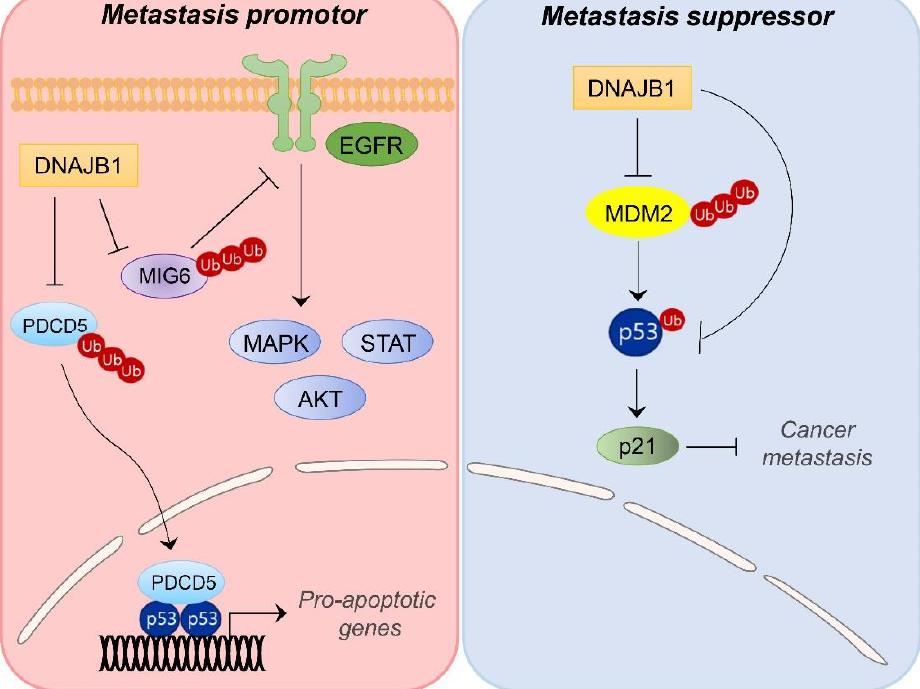
Figure 3. Schematic model showing divergent roles of DNAJB1 in cancer metastasis. DNAJB1 can play as a metastasis promoter or suppressor, depending on cancer cell type and context-dependent manner.